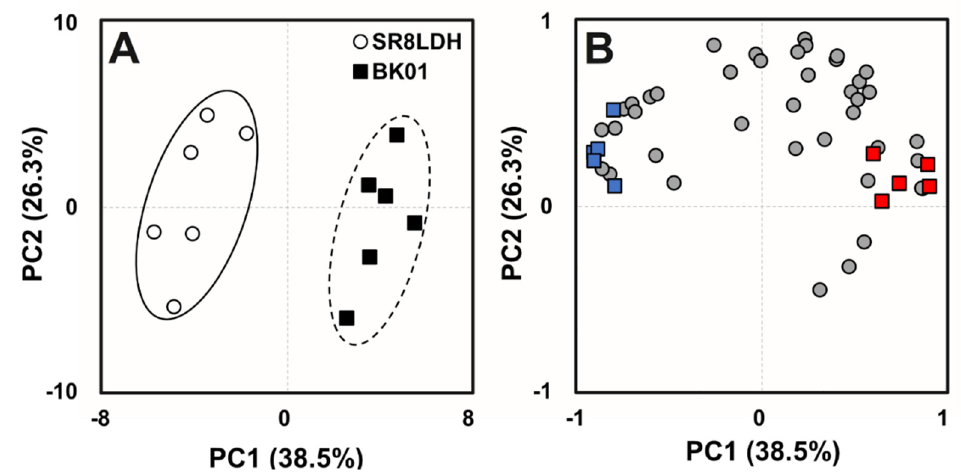
Figure 2. Principle component analysis of significantly different intracellular metabolomic profiles of SR8LDH and BK01 at a mid-exponential growth phase without lactic acid stress on ( A ) a score plot and ( B ) a loading plot. The colored metabolites indicate the five metabolites with the highest (red) and the lowest (blue) fold-change value among significantly different metabolites between SR8LDH and BK01. (Student’s t -test, p < 0.05), of which details can be found in Table S2. All cells were grown in complex medium containing 20 g/L glucose, under oxygen-limited conditions (80 rpm), with an initial cell concentration of 0.5 g DCW/L.